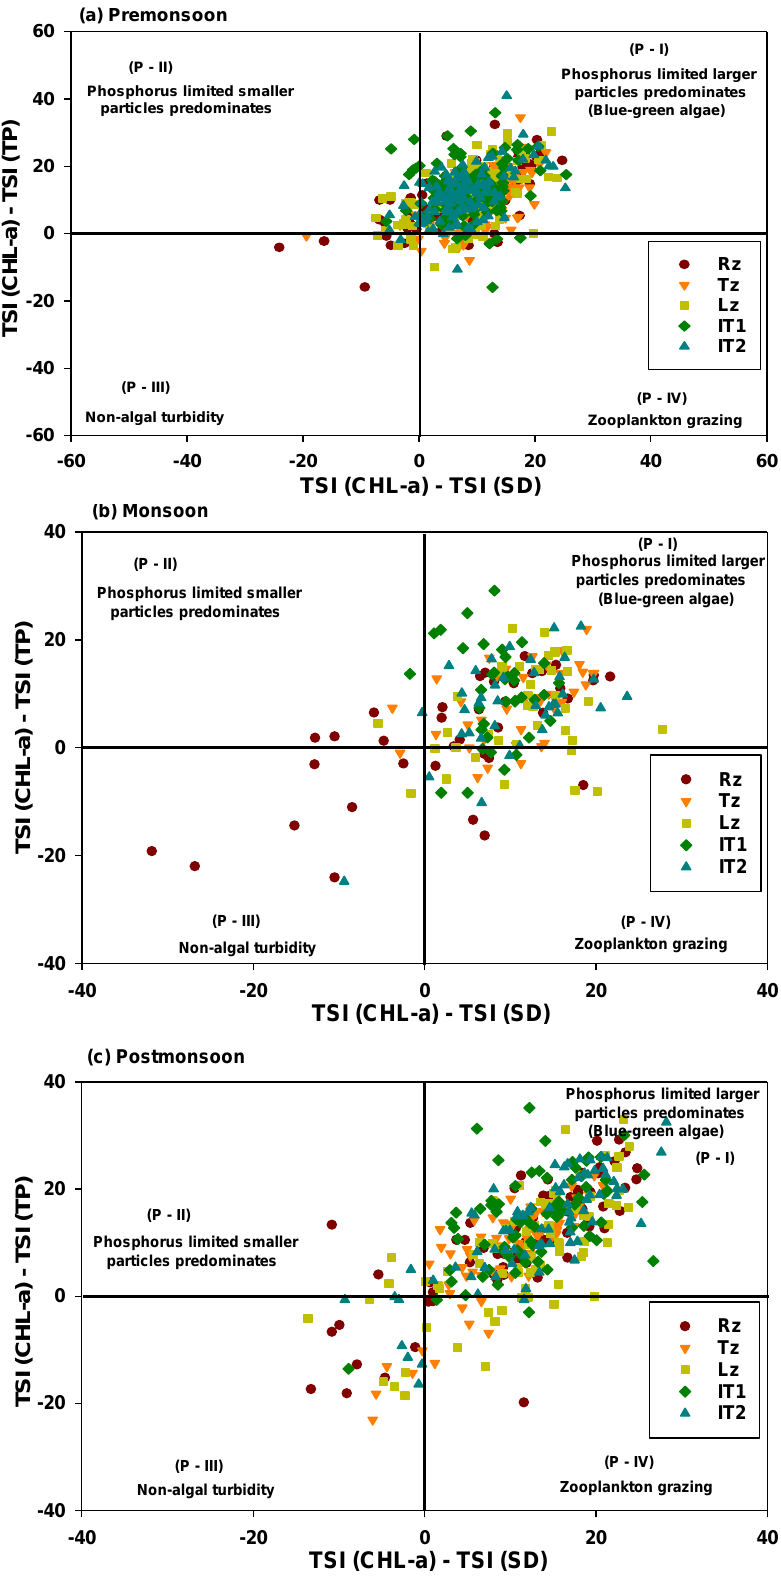
Figure 8. Analysis of trophic state index deviation from 2000–2018 during ( a ) premonsoon (January–June), ( b ) monsoon (July–August) and ( c ) postmonsoon (September–December) season in Daecheong Reservoir. (Rz: riverine zone, Tz: transitional zone, Lz: lacustrine zone, IT1, and IT2: intake tower for drinking water 1 and 2).